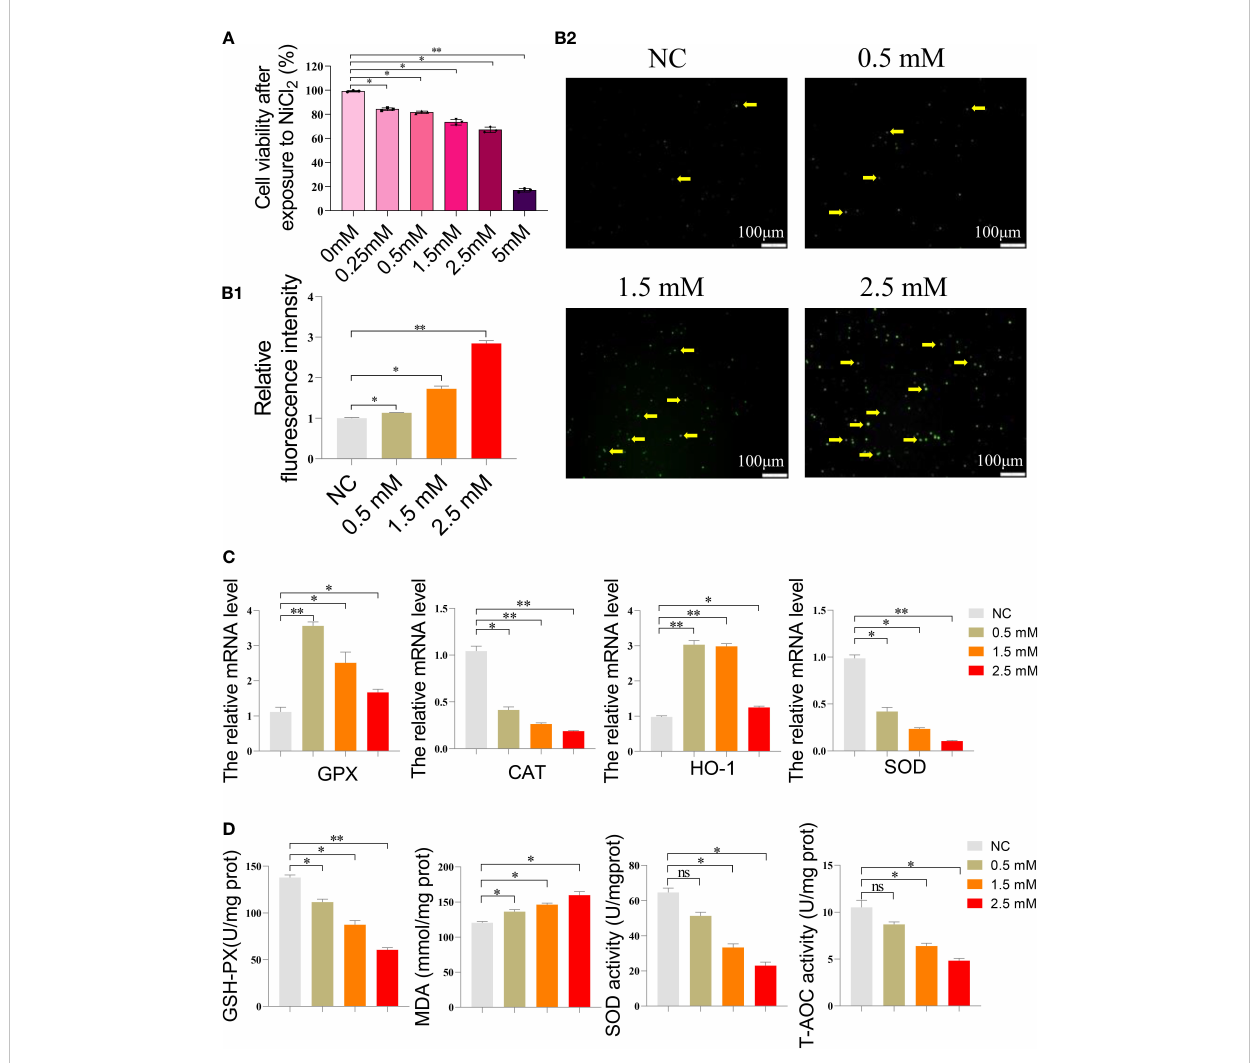
FIGURE 1 (A) Cell survival rate of spleen lymphocytes exposed to different concentrations of NiCl (B) Reactive oxygen species (ROS) staining results of spleen 2 . lymphocytes exposed to different concentrations of NiCl 2 , The green dot pointed by the yellow arrow represents the ROS level. ImageJ analysis of the mean fl uorescence intensity of ROS staining in each group. * represents P<0.05 compared with the NC group, and ** represents P<0.01 compared with the NC group. (C) Expression of antioxidant enzyme-related gene mRNA of spleen lymphocytes exposed to different concentrations of NiCl 2 . ns represents no statistical difference between the two groups, * represents signi fi cant difference between the two groups (P<0.05), and ** represents extremely signi fi cant difference between the two groups (P<0.01). (D) After exposed to different concentrations of NiCl2, the content of GSH-Px and MDA, as well as the activity of SOD and T-AOC, were measured in spleen lymphocytes. ns represents no statistical difference between the two groups, * represents signi fi cant difference between the two groups (P<0.05), and ** represents extremely signi fi cant difference between the two groups (P<0.01). We have uploaded the revised fi